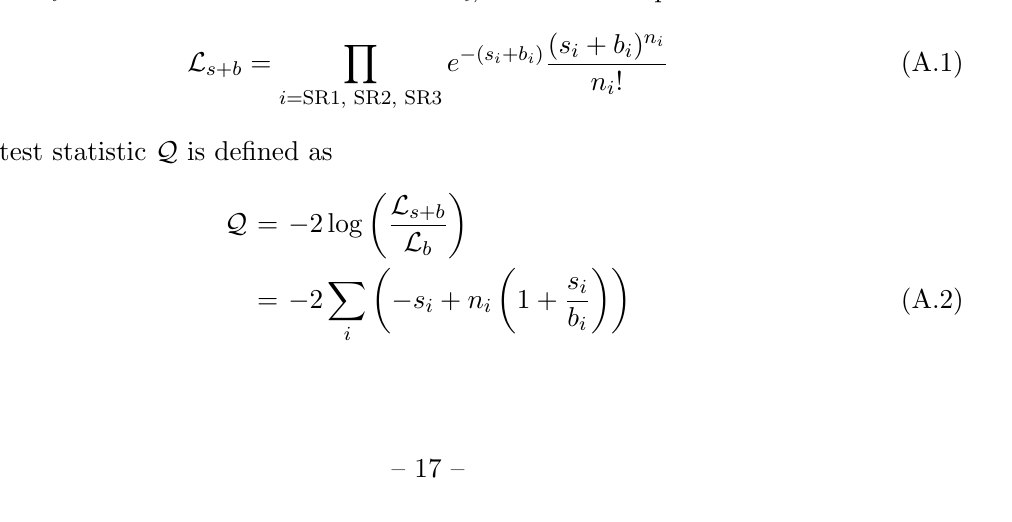
Figure 5 . Comparison of our expected signal (blue line) for the benchmark M ~ compared with published expected signal (green dots) in the three signal regions SR1 (top), SR2 (middle) and SR3